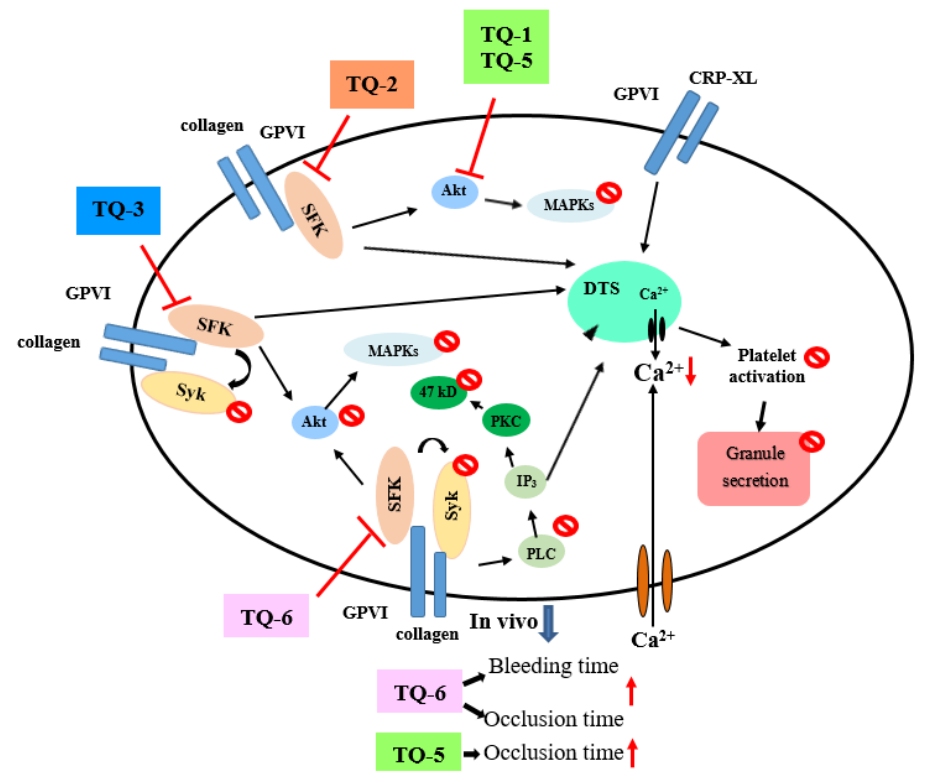
Figure 2. General representation of the main targets and proposed mechanisms of action of ruthenium compounds as antiplatelet drugs. inhibits; blocks; decrease; increase.